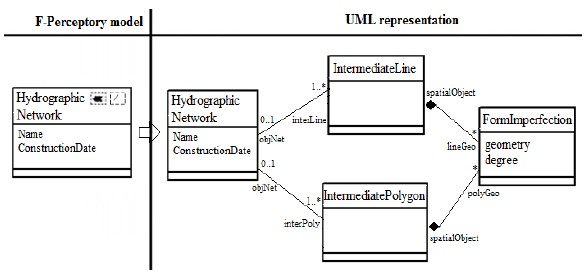
Figure 8. Fuzzy complex geometry mapping